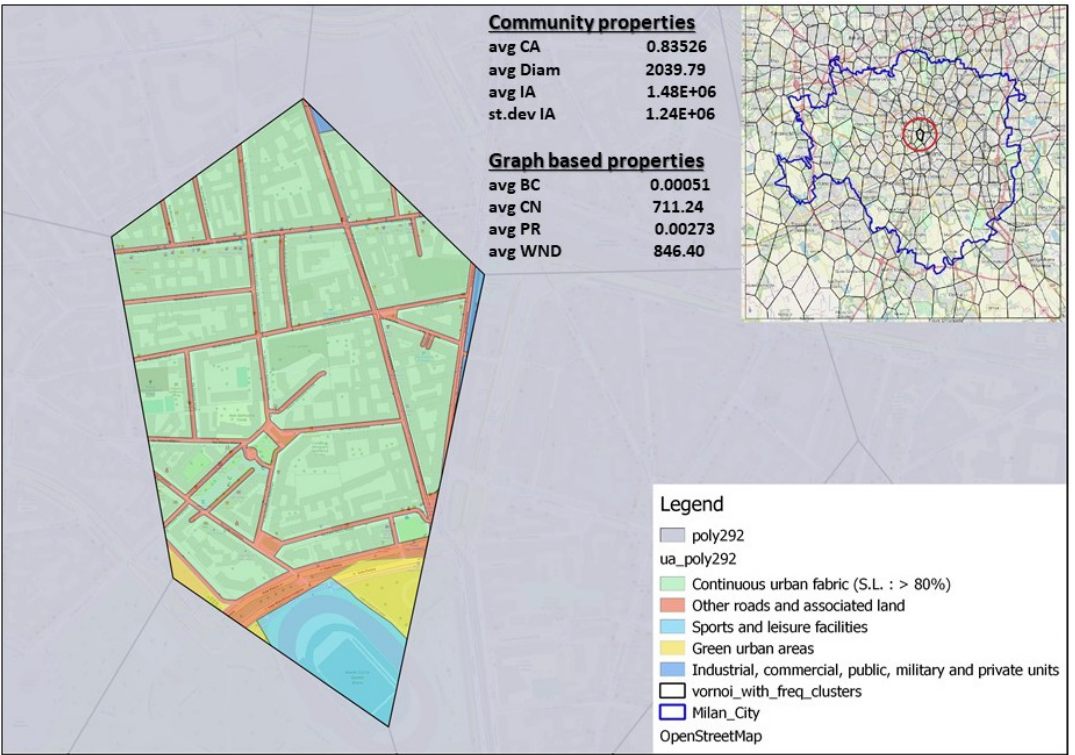
Figure 11. Land use profile of polygon where the dominant class is Continuous urban fabric (S.L.: > 80%) .